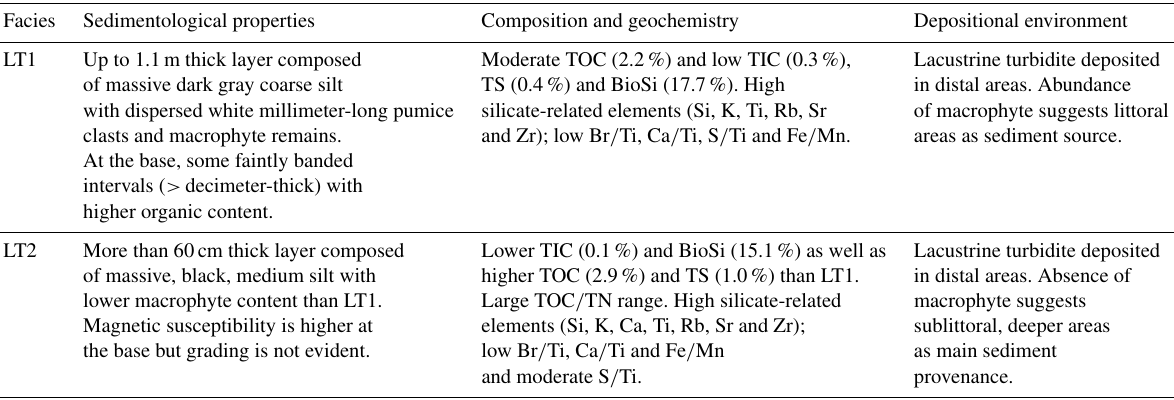
Table 3. Depositional and compositional characteristics of LdM mass wasting facies.